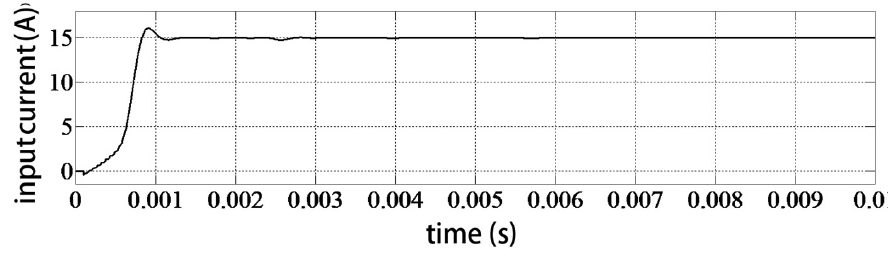
Figure 9. Improved zero-beat control strategy output current and voltage waveforms.